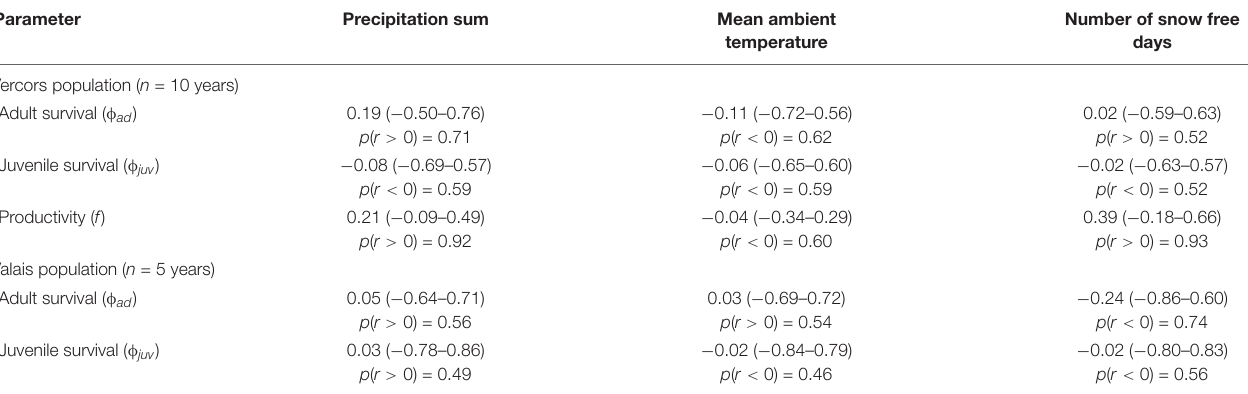
TABLE 2 | Mean Pearson’s correlation coefficients r (with 95% credible intervals) between annual demographic rates and weather variables during the breeding season in two different populations of ring ouzels in the Alps, along with the probability of the correlation coefficient to be positive or negative, depending on the sign of r . Parameter Precipitation sum Mean ambient